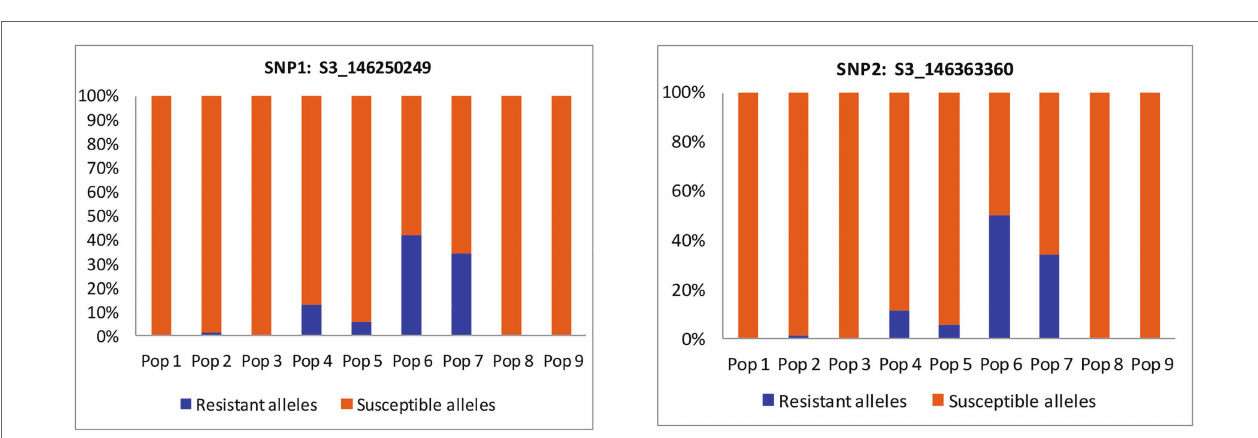
FIGURE 3 | Percent distribution of BC 3 F 2 progeny per population based on resistance and susceptibility alleles for two SNP markers linked to major quantitative trait loci (QTL) associated with resistance to